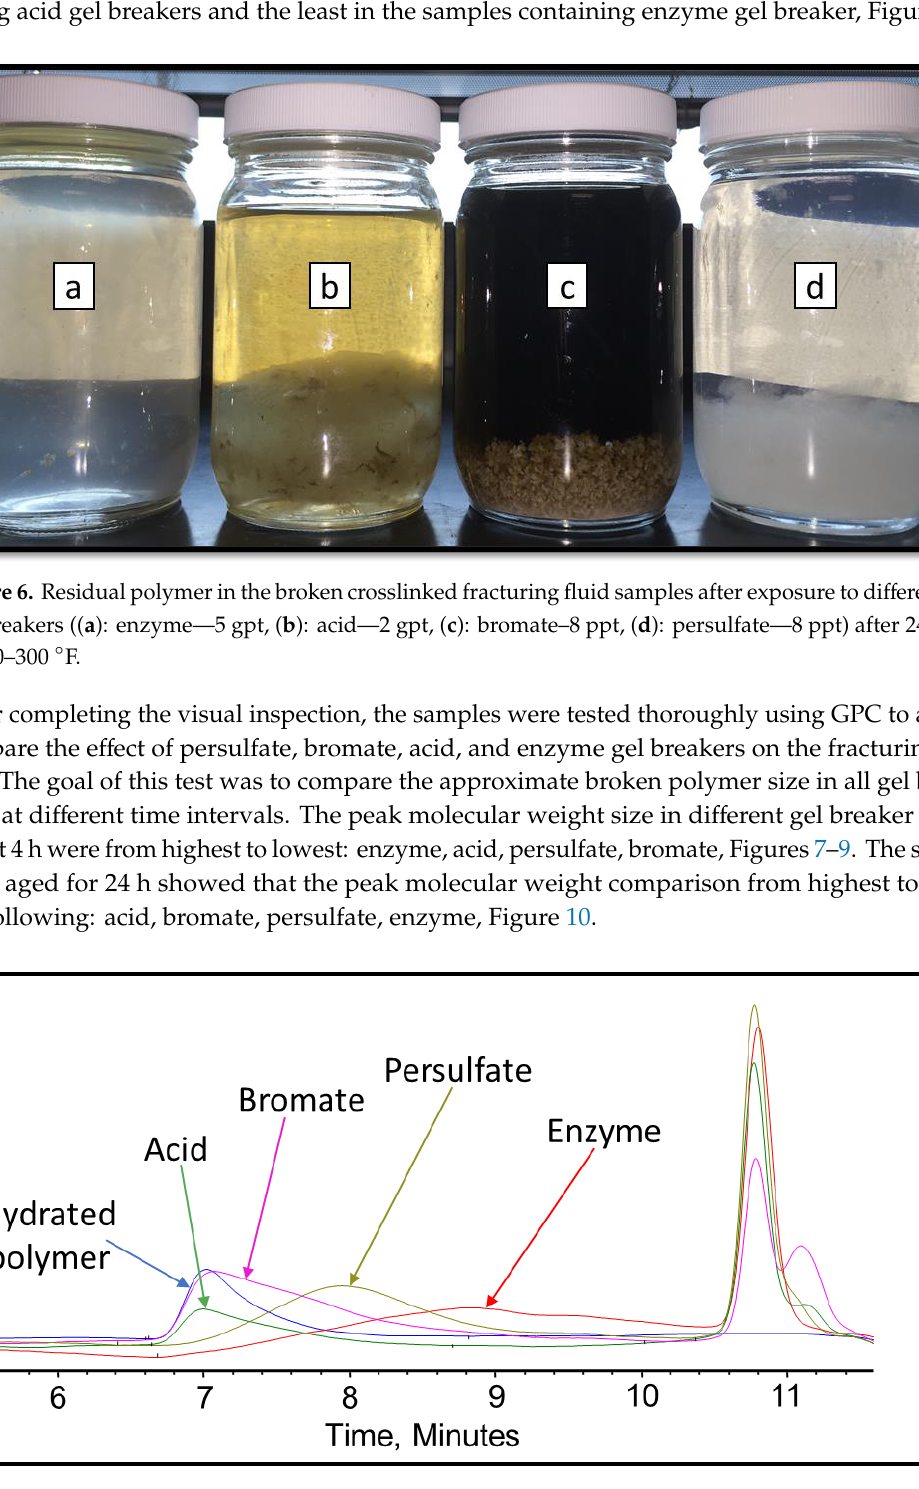
Figure 7. GPC results of the 45 lb / 1000 gal crosslinked fracturing fluid exposed to di ff erent gel breakers (persulfate: 8 ppt, bromate: 8 ppt, acid: 2 gpt, enzyme: 5 gpt) after 0.5 h at 200–300 °F.